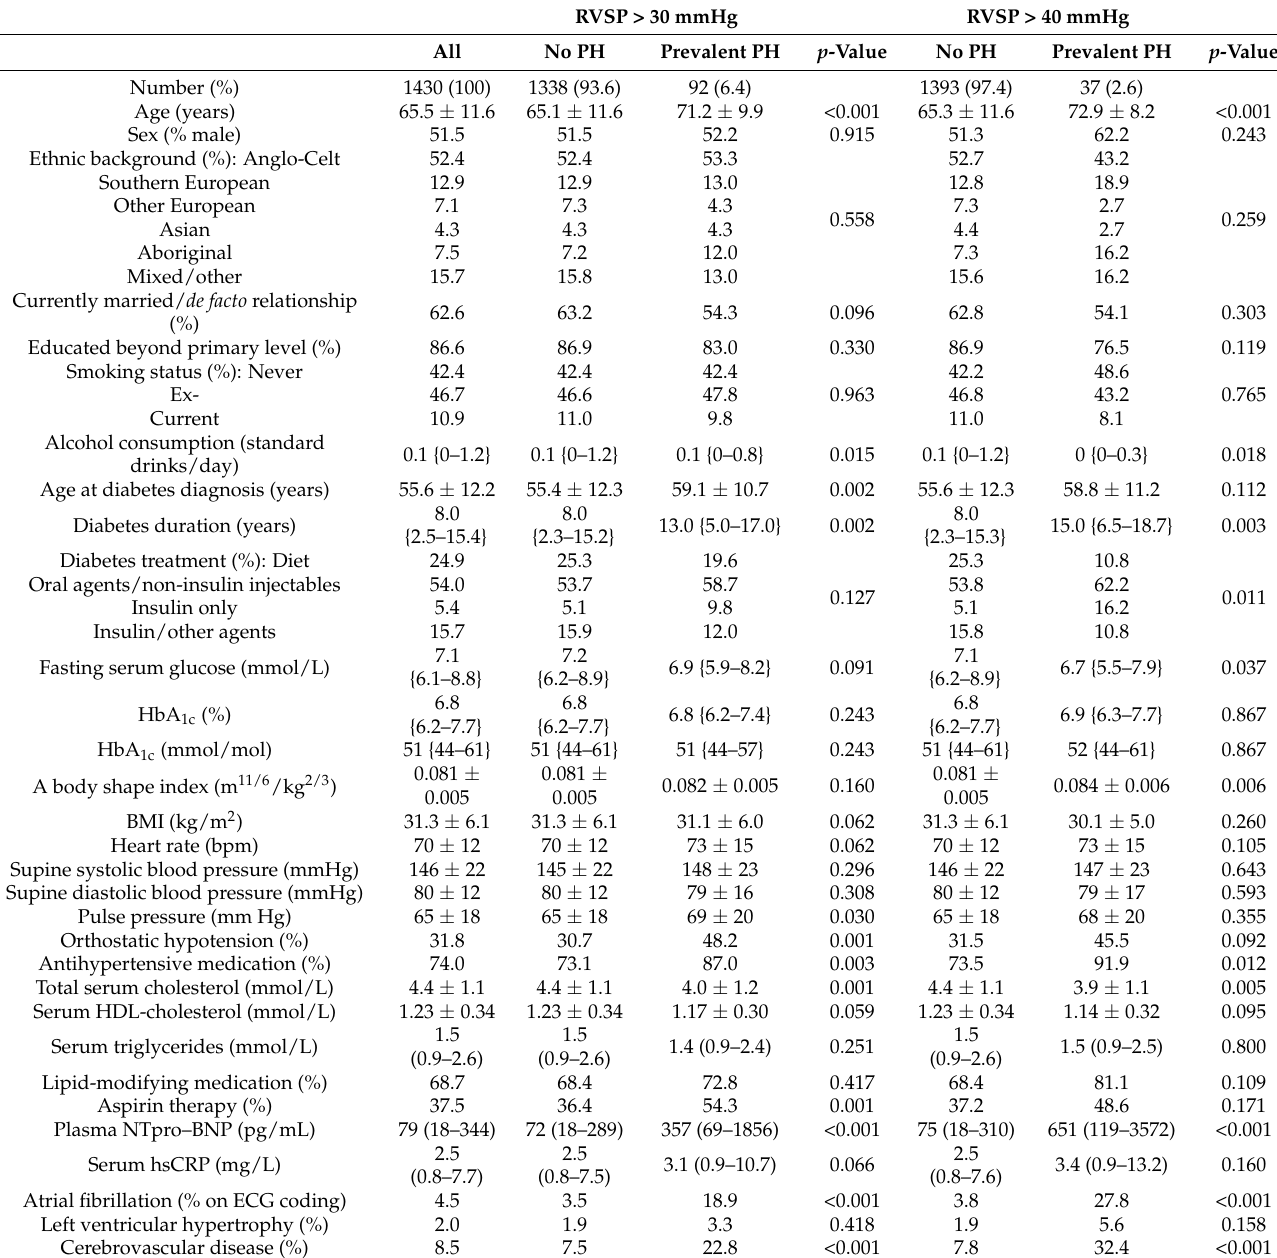
Table 1. Baseline characteristics of type 2 diabetes participants by prevalent pulmonary hypertension (PH) status. Data are percentages, mean ± SD, geometric mean (SD range) or median {inter-quartile range}. RVSP > 30